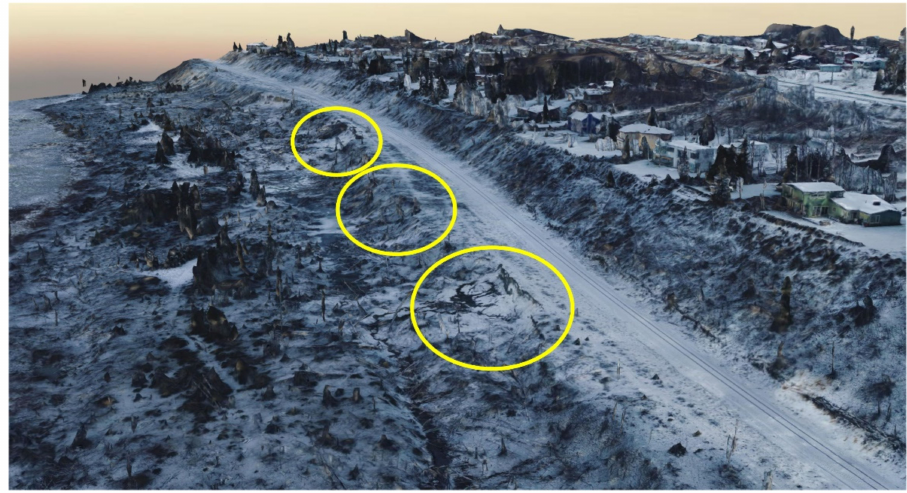
Figure 3. UAV-based 3D SfM reconstruction of an Arctic coastal slope near Anchorage that was impacted by an earthquake and landslides in 2018 (localized landslides are circled in